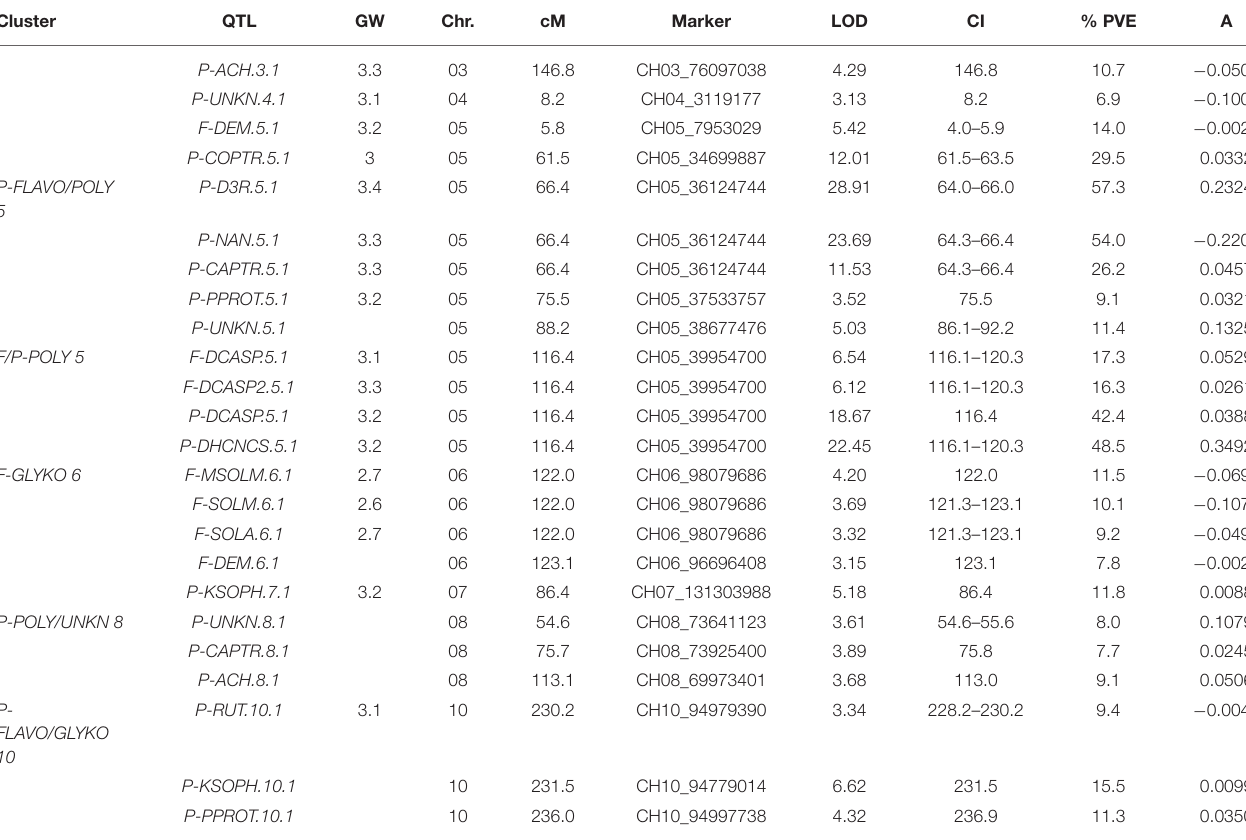
TABLE 2 | mQTLs and mQTL clusters detected in the mapping population.